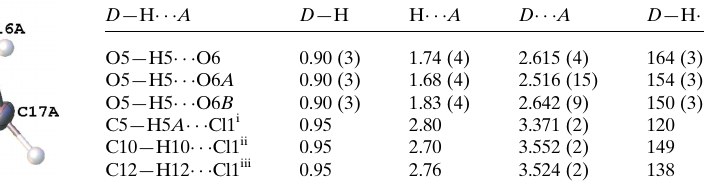
Table 2 Hydrogen-bond geometry (A˚ , (cid:5) ) for